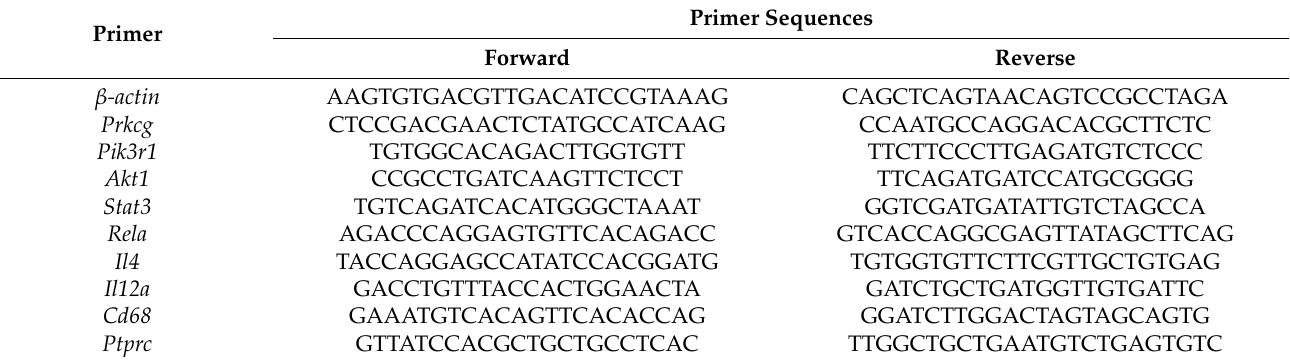
Table 2. The relative level (fold change (2 − was calculated. The experiment was performed in triplicate and repeated three times. Table 2. Primer sequences used for